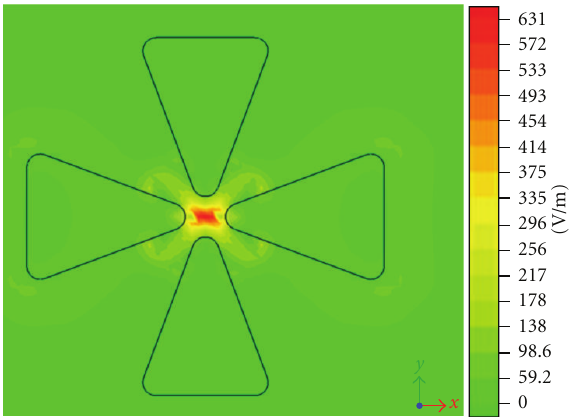
Figure 9: Electric field distribution on 45 ◦ double bowtie antenna at 151 THz due to y -polarized plane wave incidence.